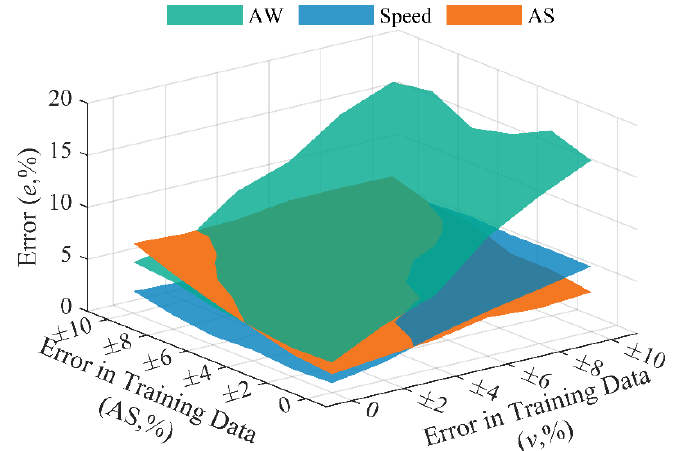
Figure 12. Identification error (%) of BwimNet with error-included training data of speed and axle spacing (Two-axle Trucks).